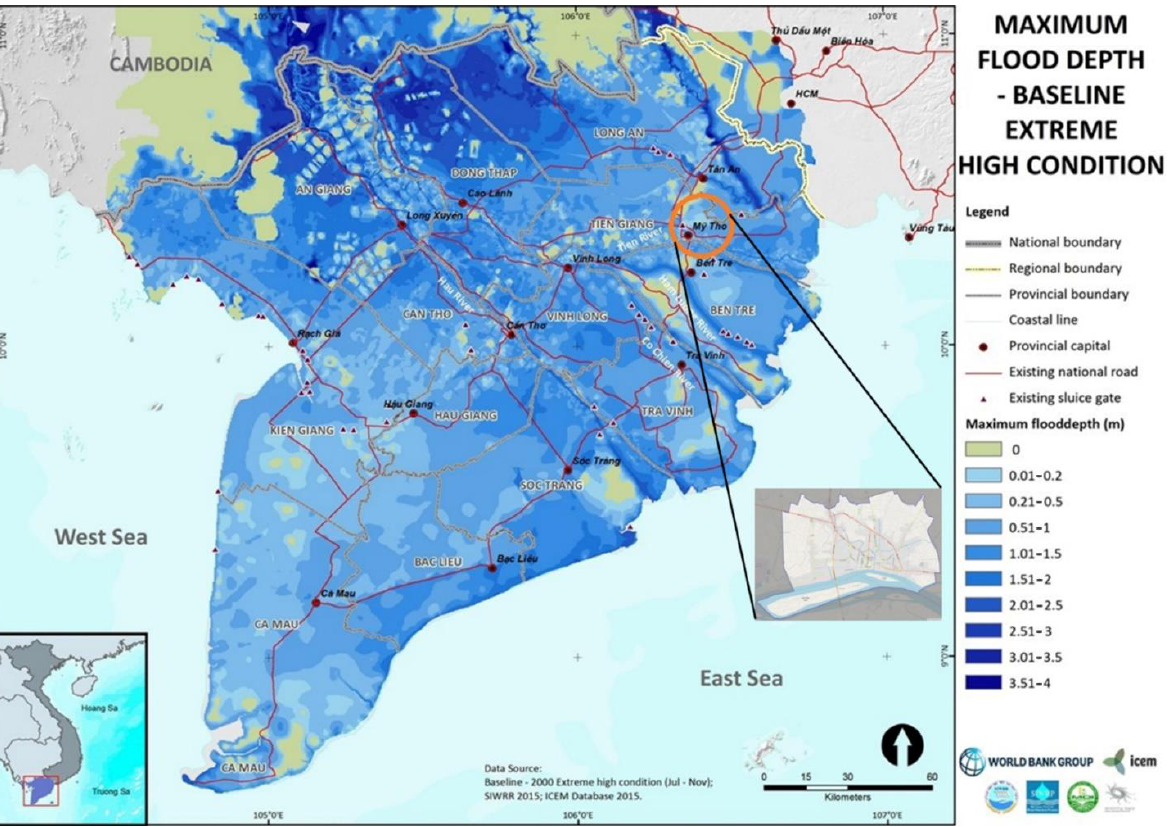
Figure 1. Map of the study area, showing the location of the Vietnamese Mekong Delta (VMD) and My Tho City (highlighted circle) with the maximum flood depth. Sources: Reproduced from ICEM—International Centre for Environmental Management (https://icem.com.au/portfolio-items/delta-tools-a0-and-a3-maps/, accessed on 9 January 2022), and OpenStreetMap (https://www. openstreetmap.org/, accessed on 9 January